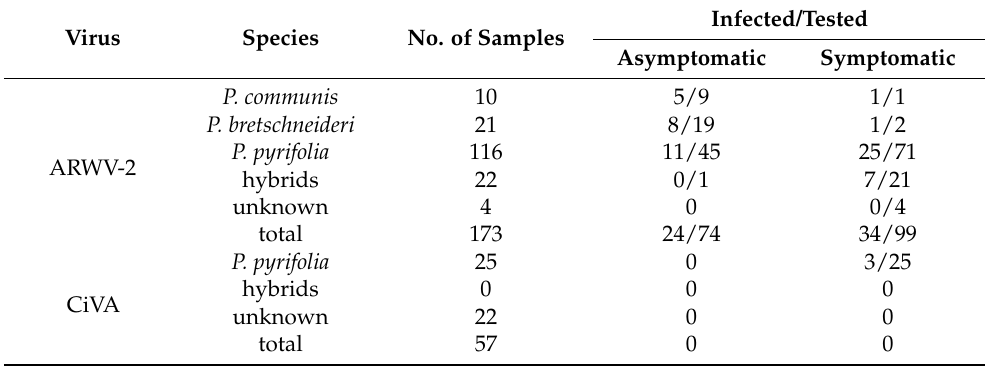
Table 4. Incidence of ARWV-2 and CiVA in the pear leaf samples of five provinces of China as detected by